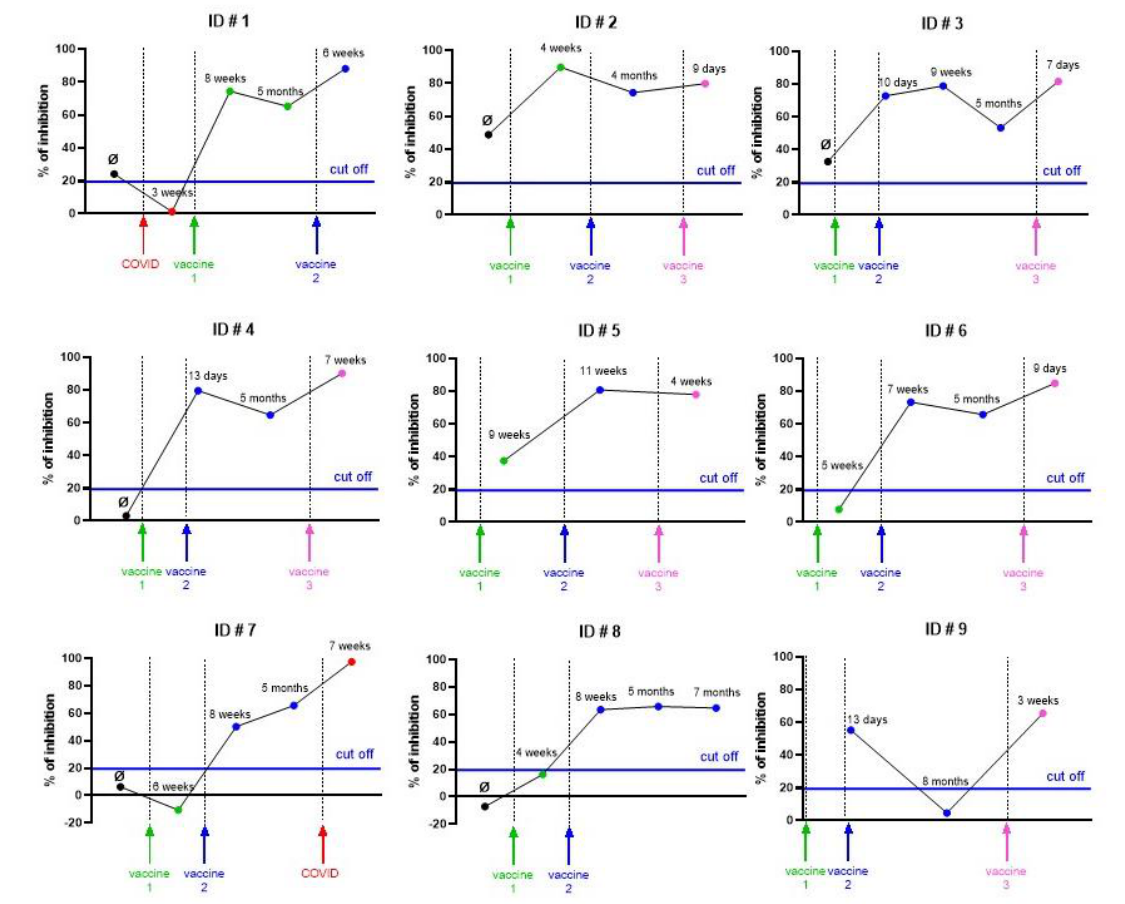
Figure 7. Case-reports of fusion inhibition after mRNA vaccination. Sera (1/32 dilution) from nine volunteers ( ID#1 to ID#9 ) with various vaccinal schemes were analyzed for their impact on the fusion inhibition. Ø = serum before any vaccination/infection. The time of vaccination or infection is indicated by vertical arrows with a color code (red for COVID infection, green for first vaccination, blue for second vaccination and pink for third vaccination). The dots correspond to blood sampling and the time laps refer to the delay between blood sampling and the previous vaccination/infection. Each luminescent signal is normalized with the value in the presence of an internal control, made of a pool of seronegative sera. Results are expressed as the percentage of inhibition compared to the internal control